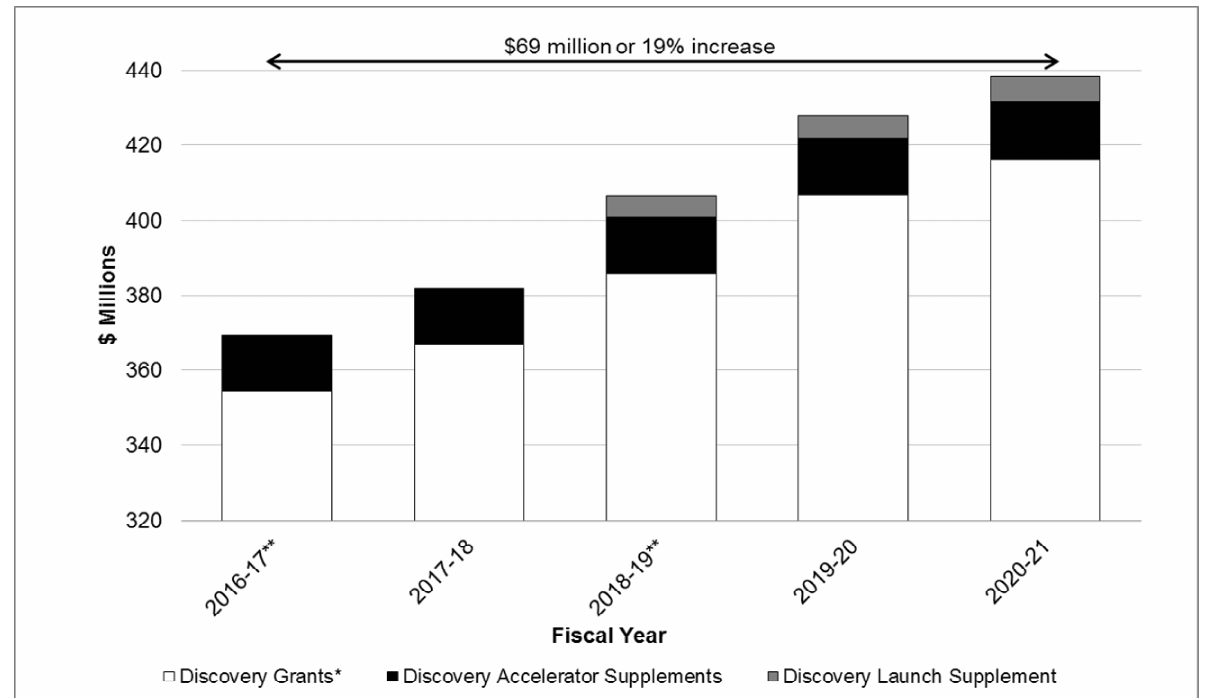
Planned investments in the Discovery Grants Program Elements, 2016-17 to